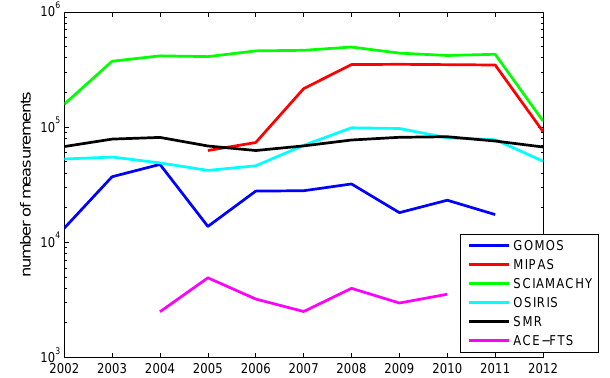
Figure 1. Number of measurements in each year and for each in- strument. Number of MIPAS and SCIAMACHY measurements de- crease significantly in 2012 due to the loss of Envisat. GOMOS data from year 2012 are not included in HARMOZ, because GOMOS experienced instrumental problems at that